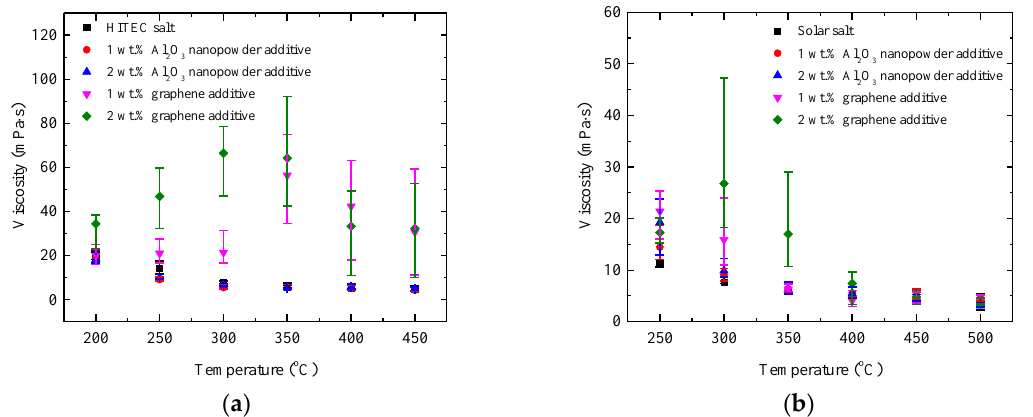
Figure 10. Viscosities of salt and nanocomposites against different temperatures. ( a ) HITEC salt and its nanocomposites, ( b ) solar salt and its nanocomposites. Table 3. Average dynamic viscosities of salts and nanocomposites in the present study. Material Type